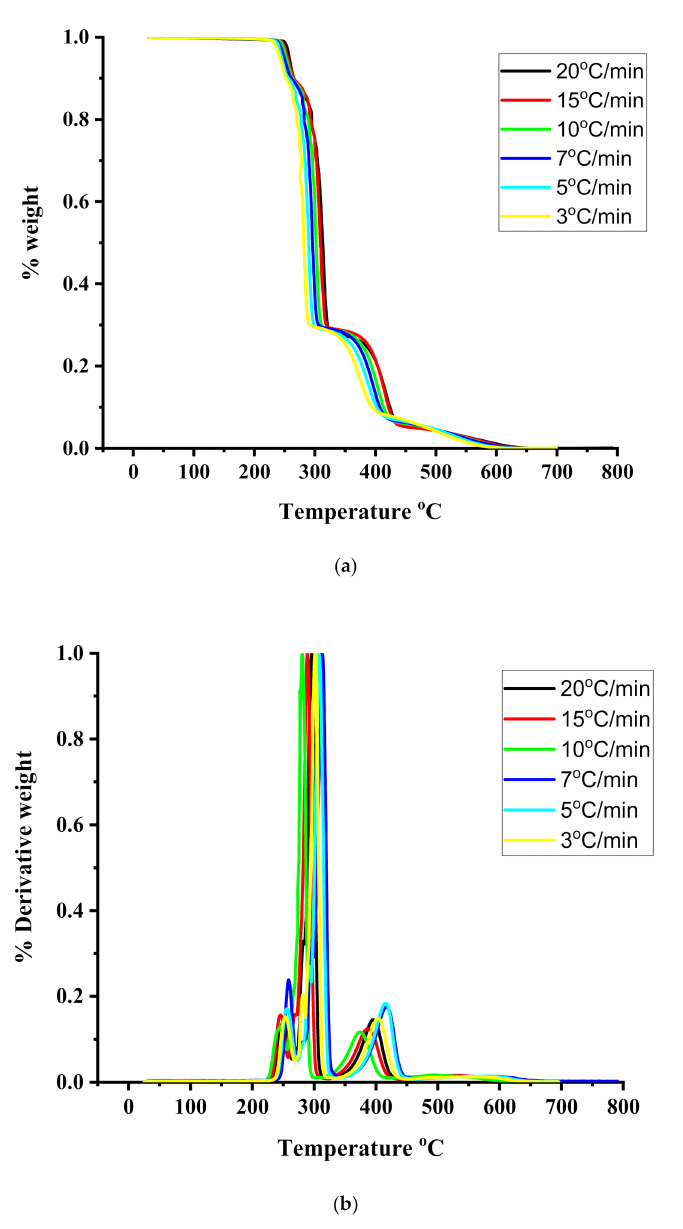
Figure 5. ( a ): TGA thermograms for the sample R20/80 under different heating rates. ( b ): DTG thermograms for the sample R20/80 under different heating